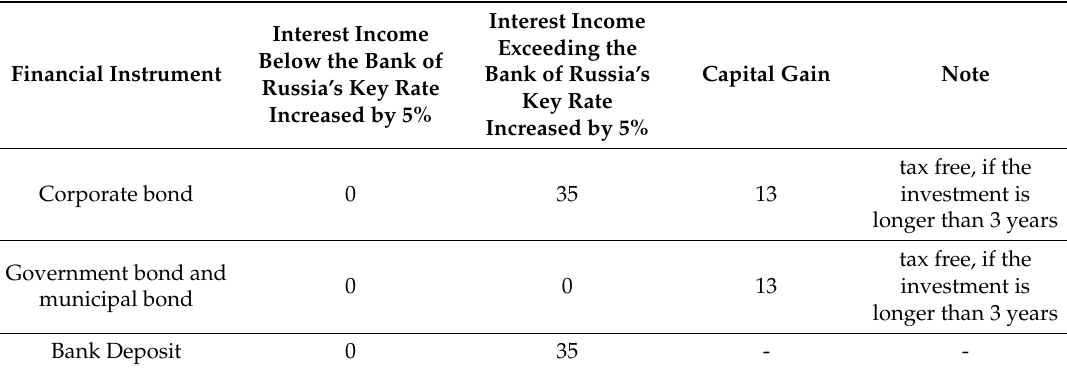
Table 2. Incomes taxation of Russian retail investors in Bonds and Deposits, %.